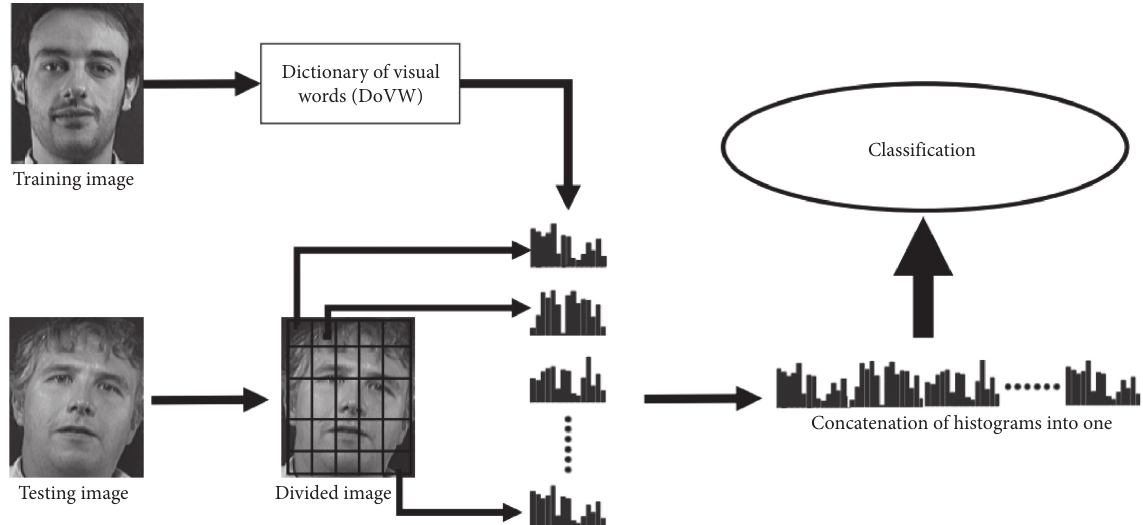
Figure 3: The overall face recognition system using a new local descriptor based on